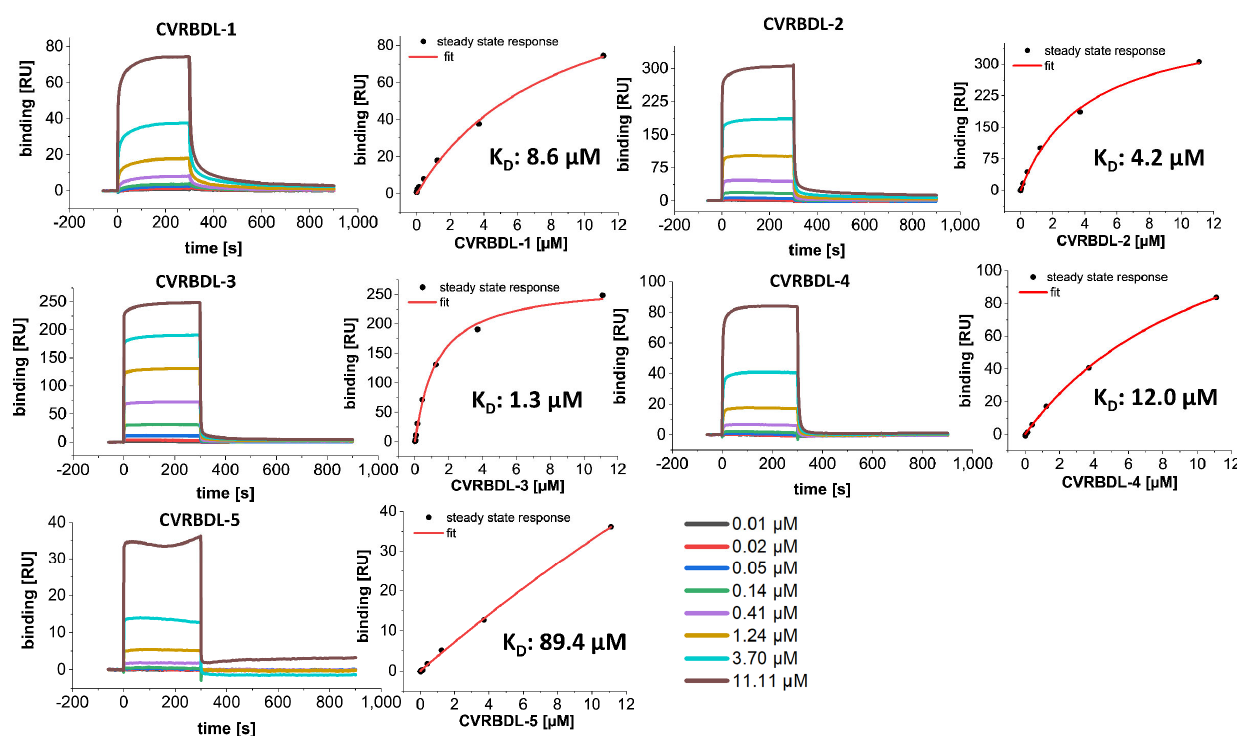
Figure 3. SPR affinity measurement of compounds CVDRBDL-1 to -5 on the immobilized SARS-CoV-2 RBD selection target. The C-terminally biotinylated SARS-CoV-2 RBD was immobilized on a streptavidin-derivatized sensor surface in a T200 SPR device (SA, Cytiva, USA). The compounds were injected for 300 s with 30 µ L/min in a range of 0.01 to 11.11 µ M in 10 mM HEPES (pH 7.4), 150 mM NaCl, 3 mM EDTA, 0.005% ( v / v ) Tween-20. Surface regeneration in between cycles was performed using 30 s injections of an acidic regeneration cocktail (pH 5.0), (0.15 M oxalic acid, 0.15 M H 3 PO 4 , 0.15 M formic acid, 0.15 M malonic acid). The K D was determined by steady state fit as follows: CVRBDL-1: 8.6 µ M ± 1.3 µ M; CVRBDL-2: 4.2 µ M ± 0.38 µ M; CVRBDL-3: 1.3 µ M ± 0.12 µ M; CVRBDL-4: 12.0 µ M ± 0.87 µ M; CVRBDL-5: 89.4 µ M ± 32.0 µ M. K D evaluation was performed using the Biacore T200 data evaluation software v. 3.2 with offset set to